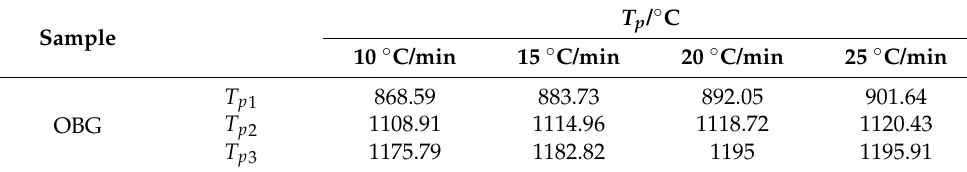
Figure 3. DSC curves of the OBG measured at different heating rates. Table 2. Peak temperature ( T p ) of crystallization of the OBG at distinct heat rates.